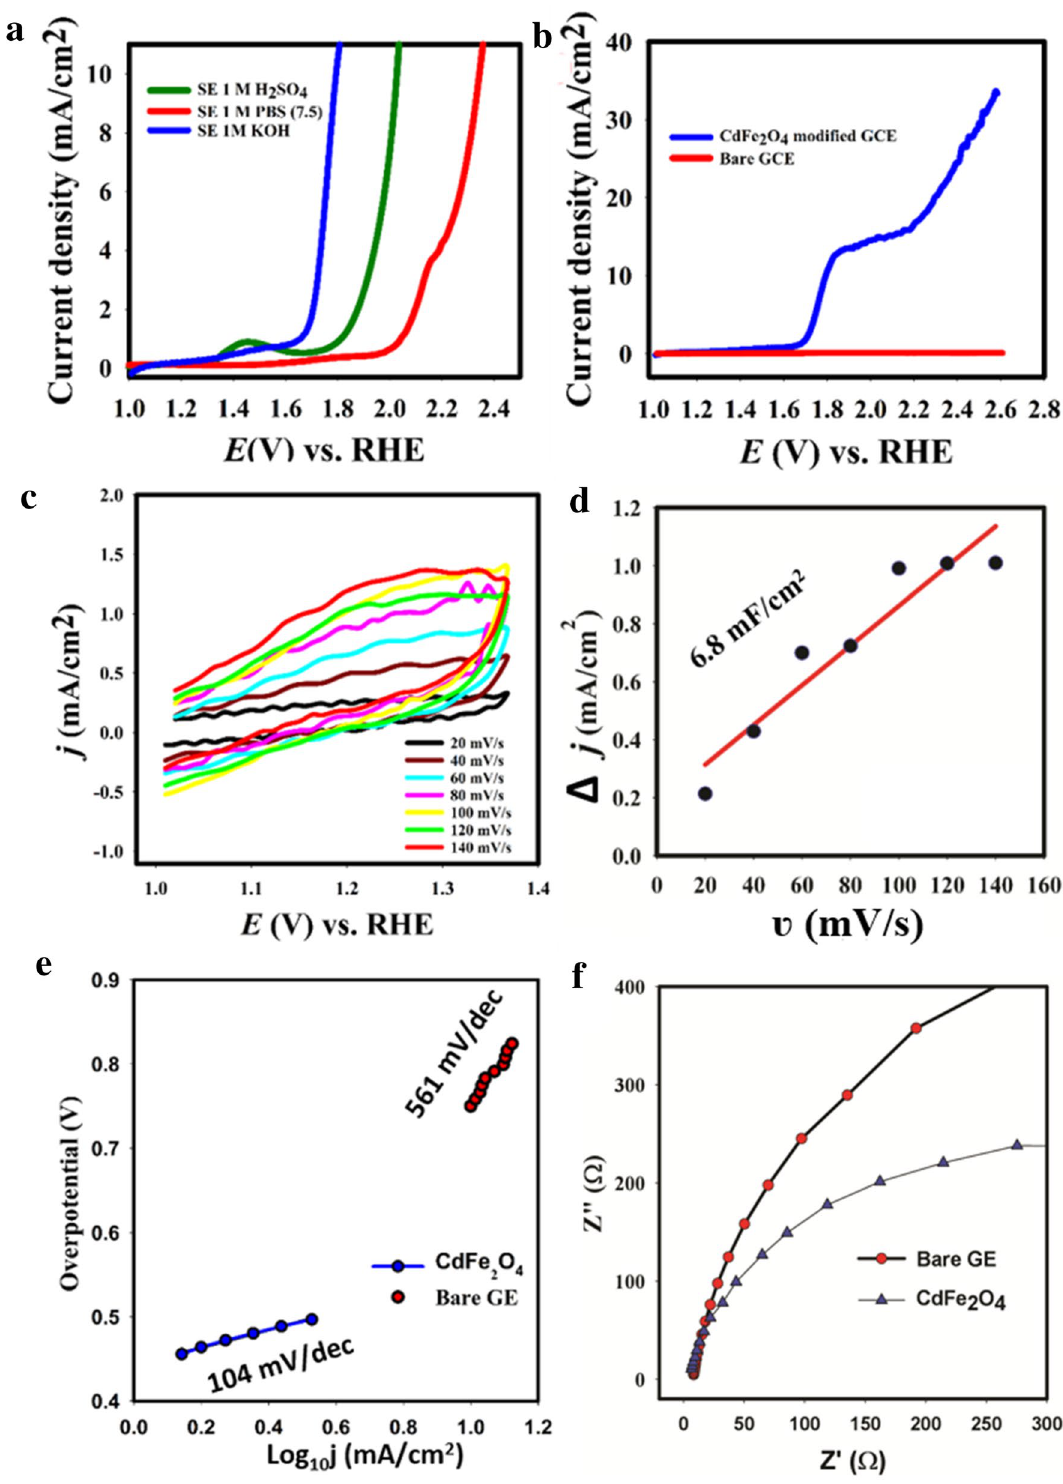
Figure 3. OER reaction studies: ( a ) Supporting electrolyte optimization. ( b ) Control study. ( c ) Effect of scan rate on OER. ( d ) Double layer capacitance (Cdl) determination ( e ) Tafel slope for OER reaction. ( f ) EIS spectrum of CdFe 2 O